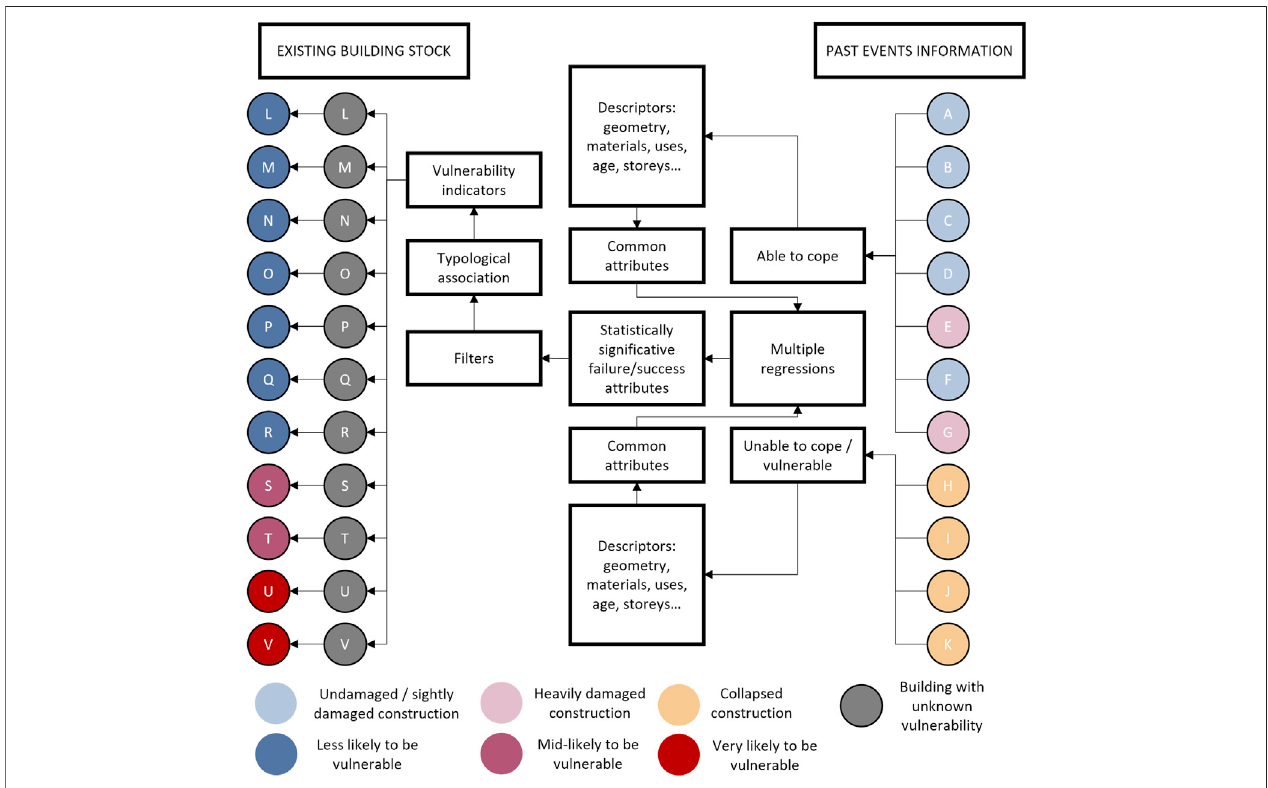
FIGURE 12 | Example of work fl ow for analysing past-events data for assessing existing buildings. Buildings on the right side (letters A to K) were assessed after a determinedseismicevent,feedingaseries ofprocesses (inthemiddle)to fi ndthetypology ’ svulnerabilitysources. Buildings withanunknownlevelofvulnerability(letters L to V) are compared with these vulnerability sources to identify the structures that are potentially more prone to damage in the sequence of a future seismic event.